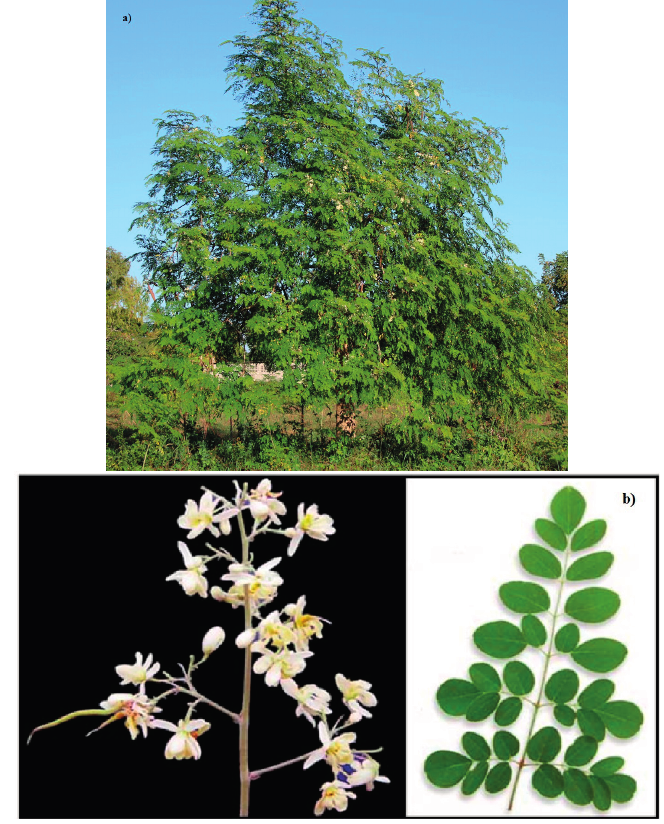
Figure 1. ( a ) A tree of Moringa oleifera ; ( b ) Moringa flowers and